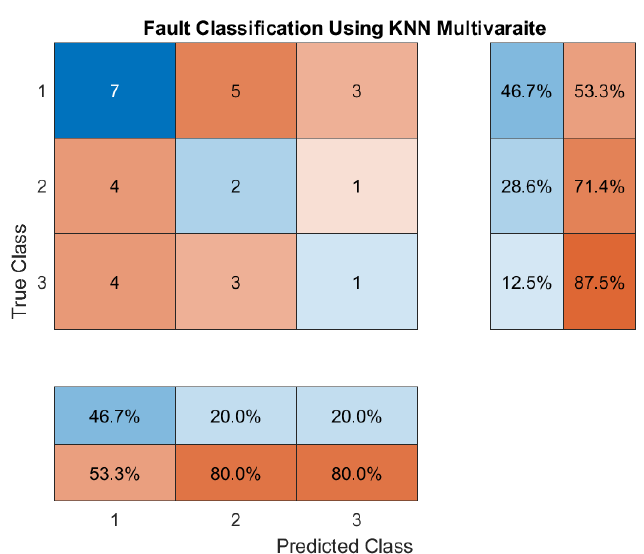
Figure 12. Confusion Matrix for k-NN Multivariate Model.